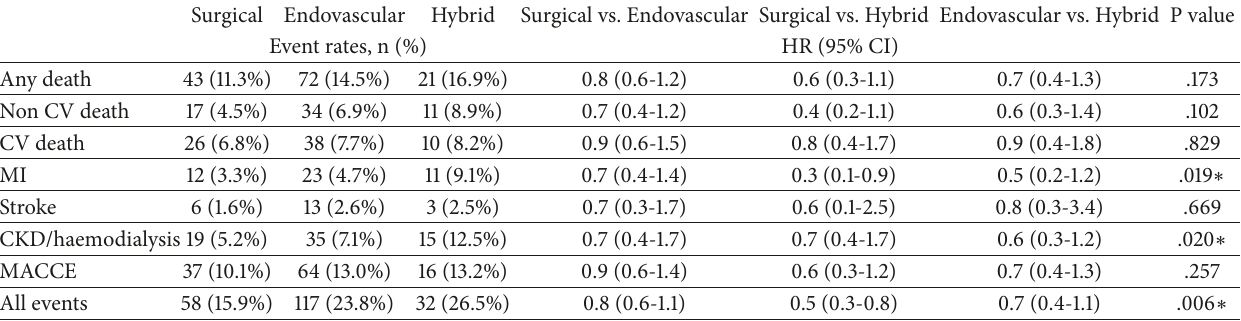
Table 3: Unadjusted comparison of primary and secondary endpoints for the 3 groups. Surgical Endovascular Hybrid Surgical vs. Endovascular Surgical vs. Hybrid Endovascular vs. Hybrid P